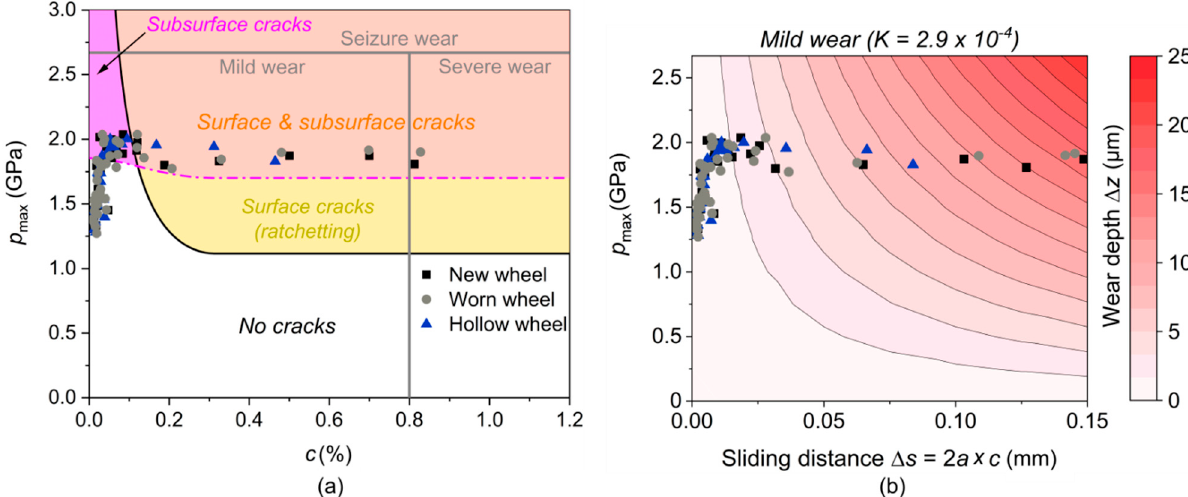
Figure 14. Wear and RCF map for Mn13 assuming the properties in Table 2 and a train speed of 90 km/h. The maps include the previously determined working points for the studied run-in crossing nose: ( a ) RCF map depicting crack initiation limits and wear regimes from [30] and ( b ) wear map for the mild wear regime with absolute wear depths per contact pass.